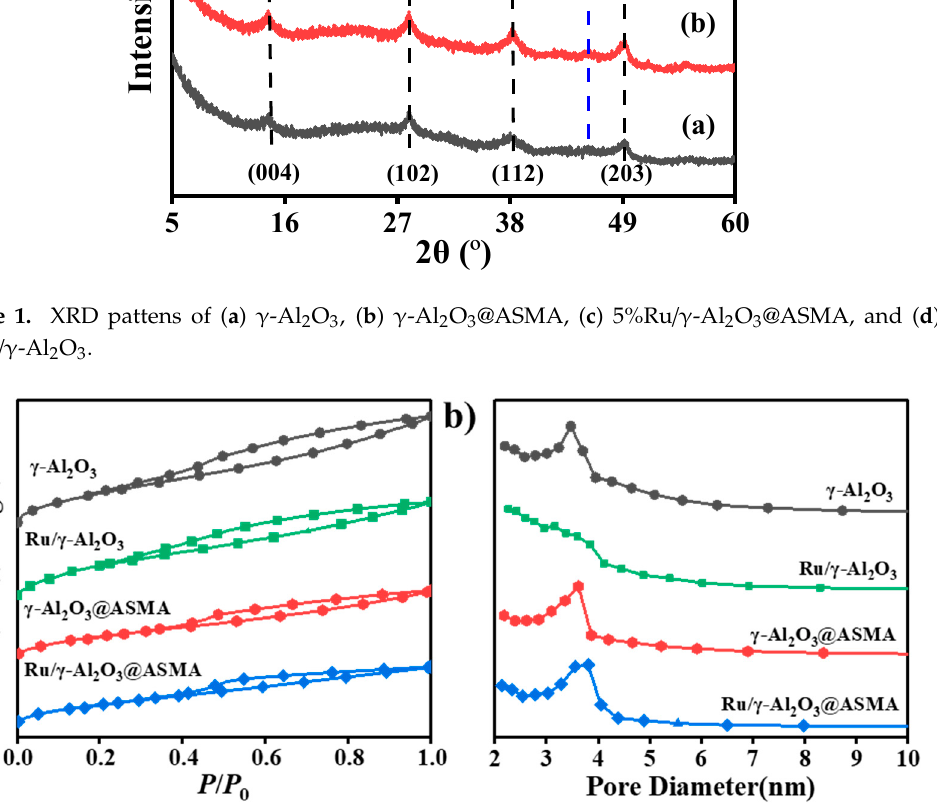
Figure 2. ( a ) N 2 -BET and ( b ) pore size distributions patterns of catalysts and intermediates.